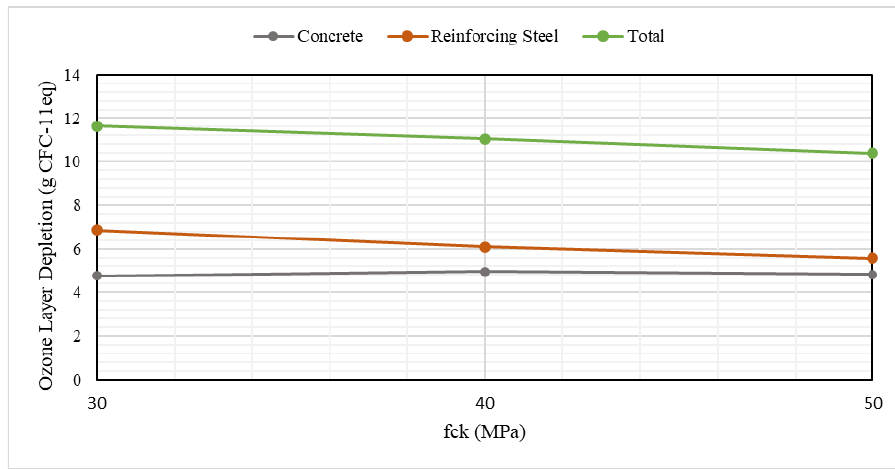
Figure 11. Ozone layer depletion for RC